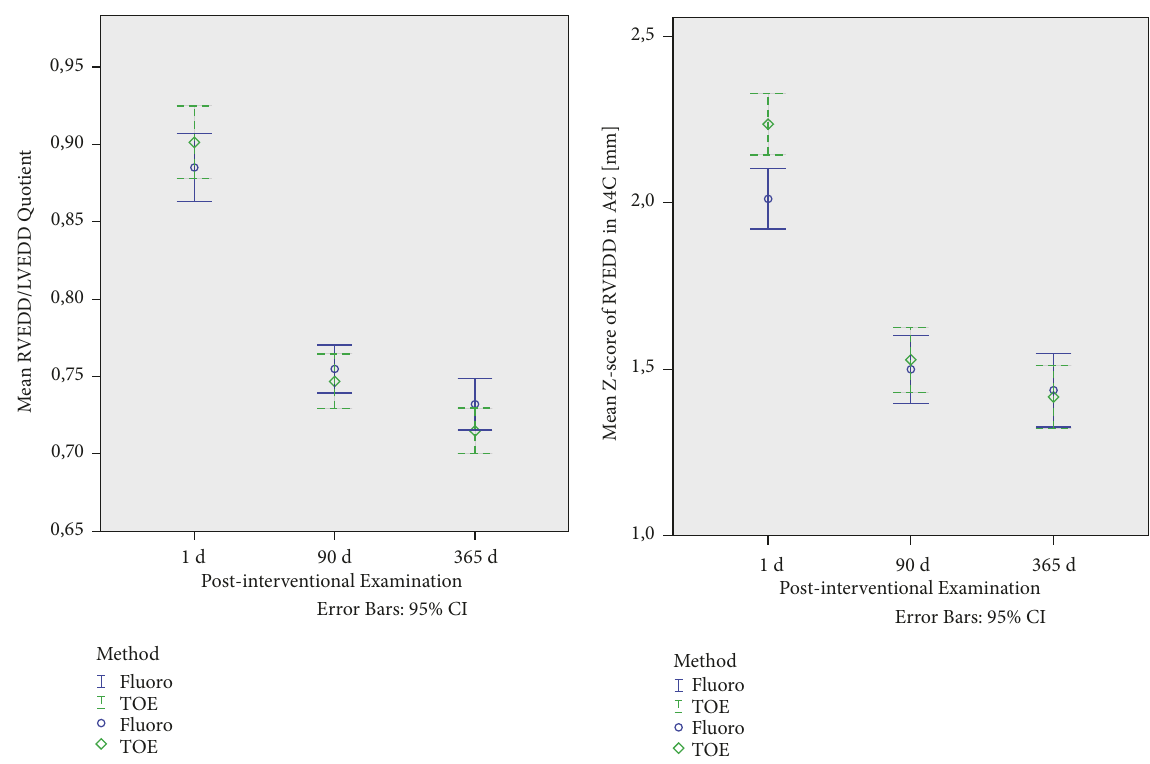
Figure 4: Postinterventional adaption of the RVEDD (z-score; right) and ratio of RVEDD to LVEDD (left) 1 day, 3 months and 1 year after intervention in the fluoroscopy group (blue line) and in the TOE alone group (green line). No relevant differences exist between the two